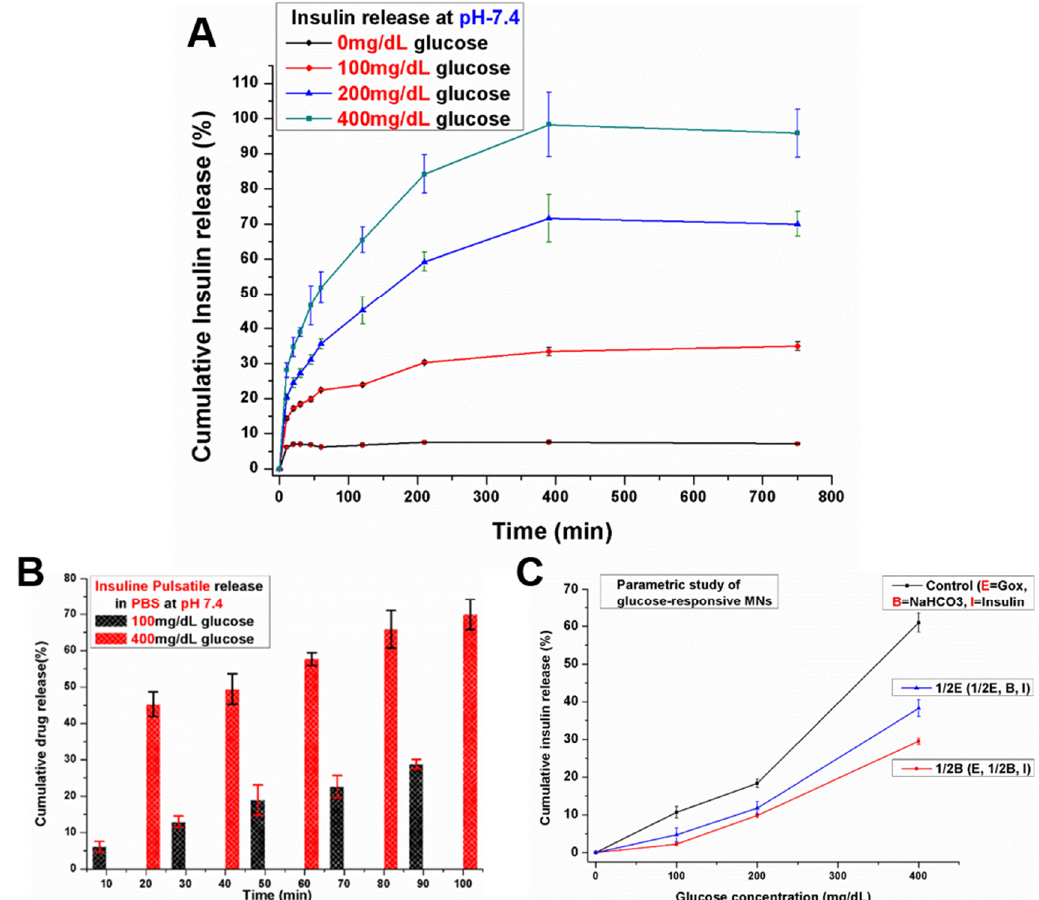
Figure 3. In vitro release profile of insulin for glucose-responsive porous polymer coated MNs incubated in phosphate buffer saline (PBS) with different glucose concentrations at 37 °C. ( A ) glucose-mediated insulin release at 0 mg/dL (black line), 100 mg/dL (red line), 200 mg/dL (blue line) and 400 mg/dL (green line); ( B ) Pulsatile release profile of insulin from porous coated MNs when the glucose concentration changed between 100 (black) and 400 (red) mg/dL alternatively for 10 min each; ( C ) The release rate (line slope) of insulin as a function of glucose concentration in the release media for {control (E, B, I)}, {1/2E (1/2E, B, I) (containing one-half amount of glucose-specific enzymes (GOx) compared to control (E, B, I))}, and {1/2B (E, 1/2B, I)}. Error bars indicate SD ( n = 5).